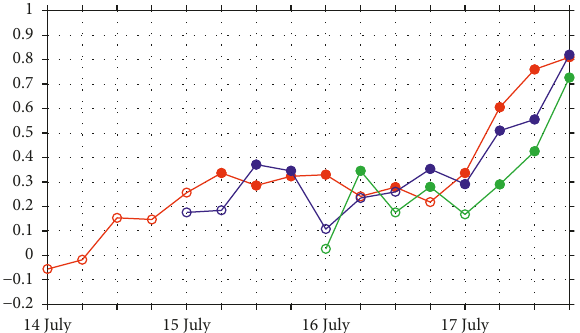
Figure 4: Time series (6h interval) of correlations between the averaged 500hPa GPHs over the SCB in forecast for next 0– 90hours after the initial time 0000 UTC 14 July and TPMVI (red line), for next 0–66 hours after the initial time 0000 UTC 15 July and TPMVI (blue line), and for next 0–42hours after the initial time 0000 UTC 16 July and TPMVI (green line). The solid dots show the correlations reaching 95% confidence level.